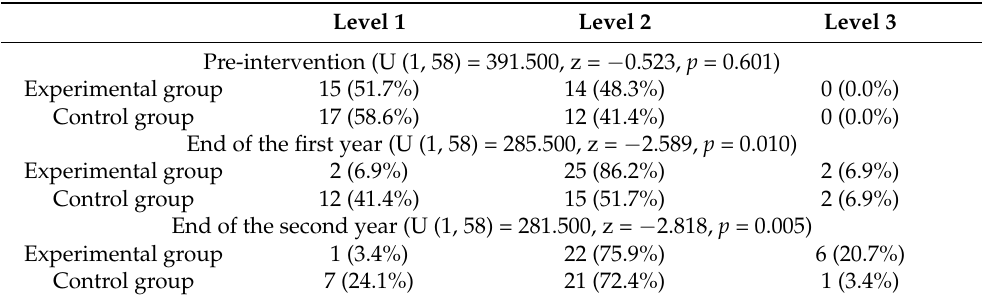
Table 1. Number and percentages of students for conceptions of career choice by group.